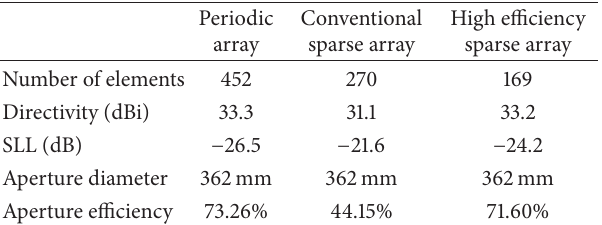
Table 4: Simulation results of three types of